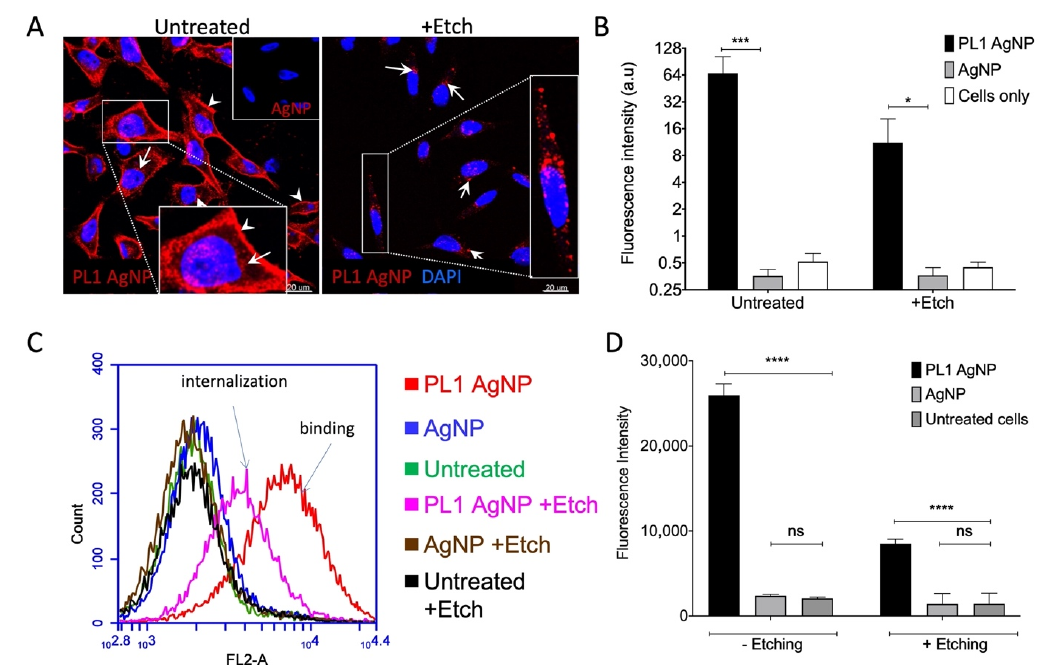
Figure 4. Cellular uptake of PL1-AgNPs. Binding and cellular uptake of PL1 or biotin-blocked CF555-labeled AgNPs in U87-MG cells was assessed by confocal imaging and flow cytometry. ( A ) Confocal microscopy of U87-MG attached cells incubated with PL1-AgNPs or control AgNPs. U87-MG cells show binding of CF555-labeled PL1-AgNP (red) to the cell surface (white arrowheads), whereas cells incubated with control particles are negative. The etched CF555-labeled PL1- AgNPs show that PL1-targeted particles are able to internalize into the cell cytoplasm (blow-up image shown in box) compare to non-targeted particles. Scale bars: 20 µm (main images) and 2 µm (insets); ( B ) Binding and internalization into cells was quantified based on CF555 signals in ( A ) of representative images (mean fluorescence intensity). Error bars: mean ± SD (N = 12), * p ≤0.05, *** p ≤ 0.001; ( C ) flow cytometry of U87-MG cells incubated with AgNPs for 1 h with ± etching. CF555-gated plot showing cell binding and internalization of PL1-AgNP (red: − etch; pink: + etch) compared to control particles AgNP (blue: − etch; brown: + etch). The cells without AgNPs were included as a control standard (green: − etch; block: + etch). ( D ) Quantification of flow cytometry data were represented as % over control cells without AgNPs, p -value was determined by one-way ANOVA, Error bars: mean ± SEM (N = 3), ns p > 0.05, * p ≤ 0.05, **** p < 0.0001.